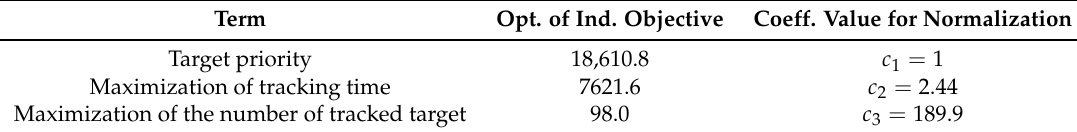
Table 7. Solution ranges of each term of objective function and proposed coefficient